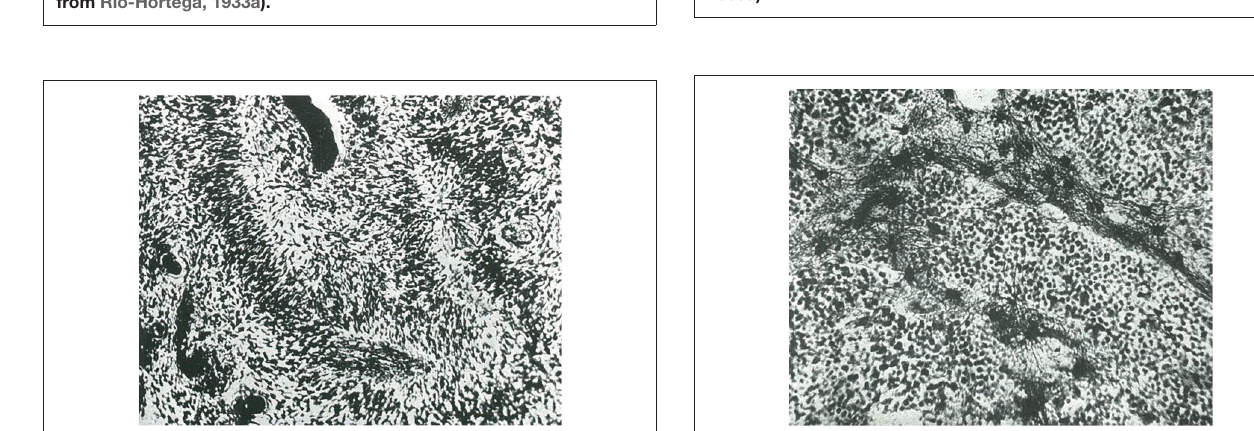
FIGURE 5 | Examples of oligodendrocytoma (taken from Río-Hortega, 1933a